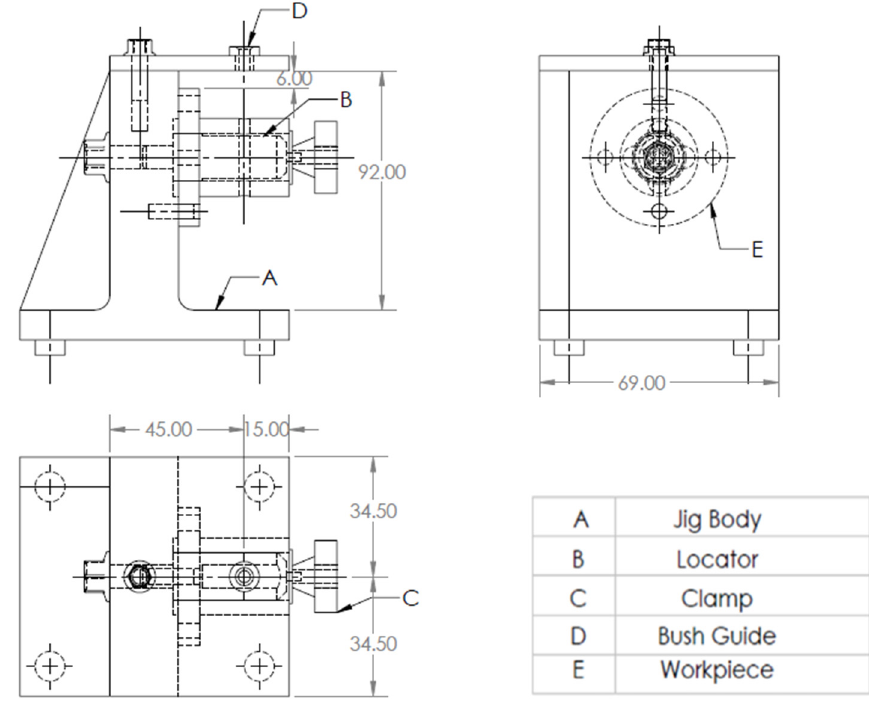
Figure 39. The drawing and isometric of the part.